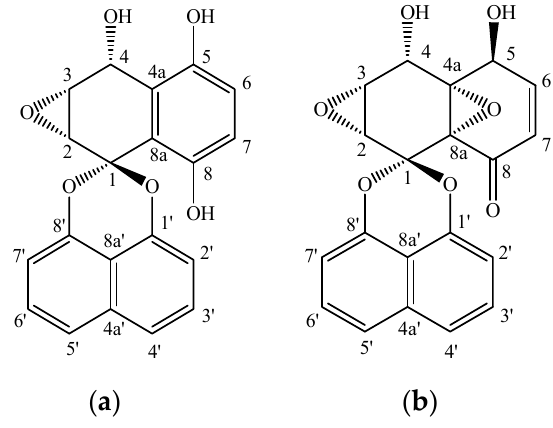
Figure 1. Chemical structures of palmarumycins C 12 ( a ) and C 13 ( b ).